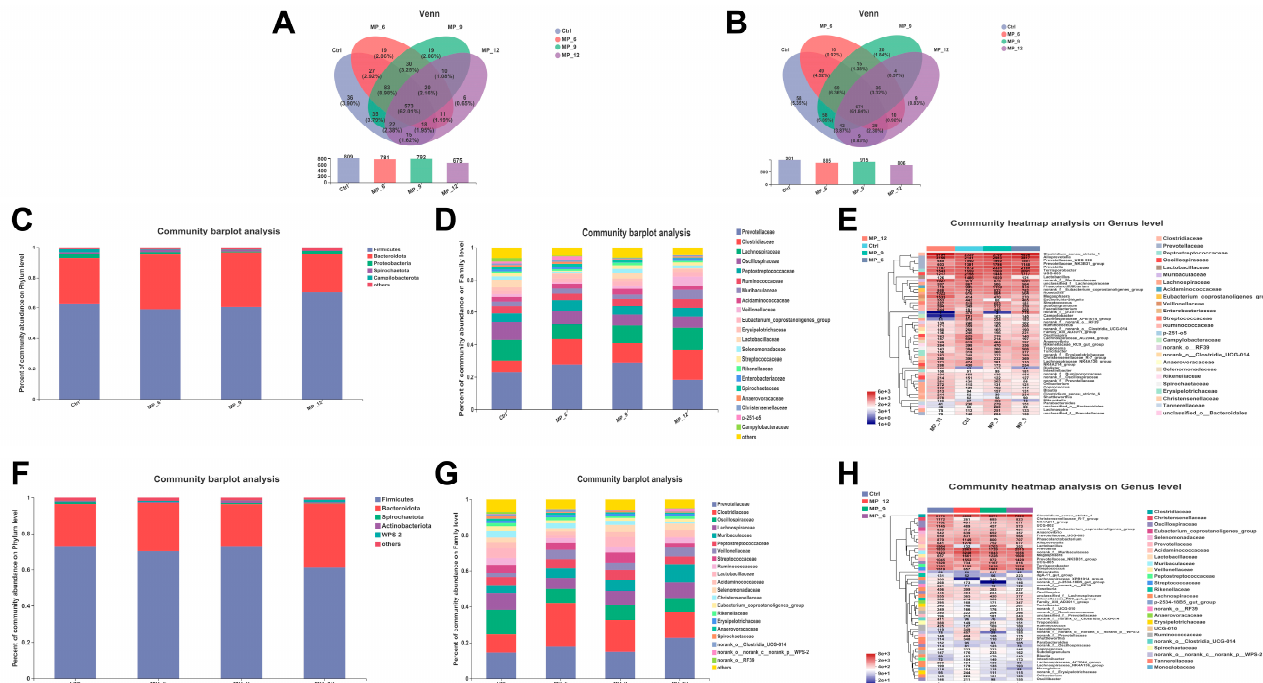
Figure 5. Overview of hindgut microbial composition in finishing pigs dietary supplementation of mulberry leaf powder of varying levels. ( A ) Venn diagram at OTU level in cecum. ( B ) Venn diagram at OTU level in colon. ( C – E ) Microbial composition at phylum, family and genus levels in cecum. ( F – H ) Microbial composition at phylum, family and genus levels in colon. Ctrl, basal diet with 0% MP; MP_6, MP_9 and MP_12 are the basal diets supplemented with 6%, 9% and 12% MP, respectively. n =